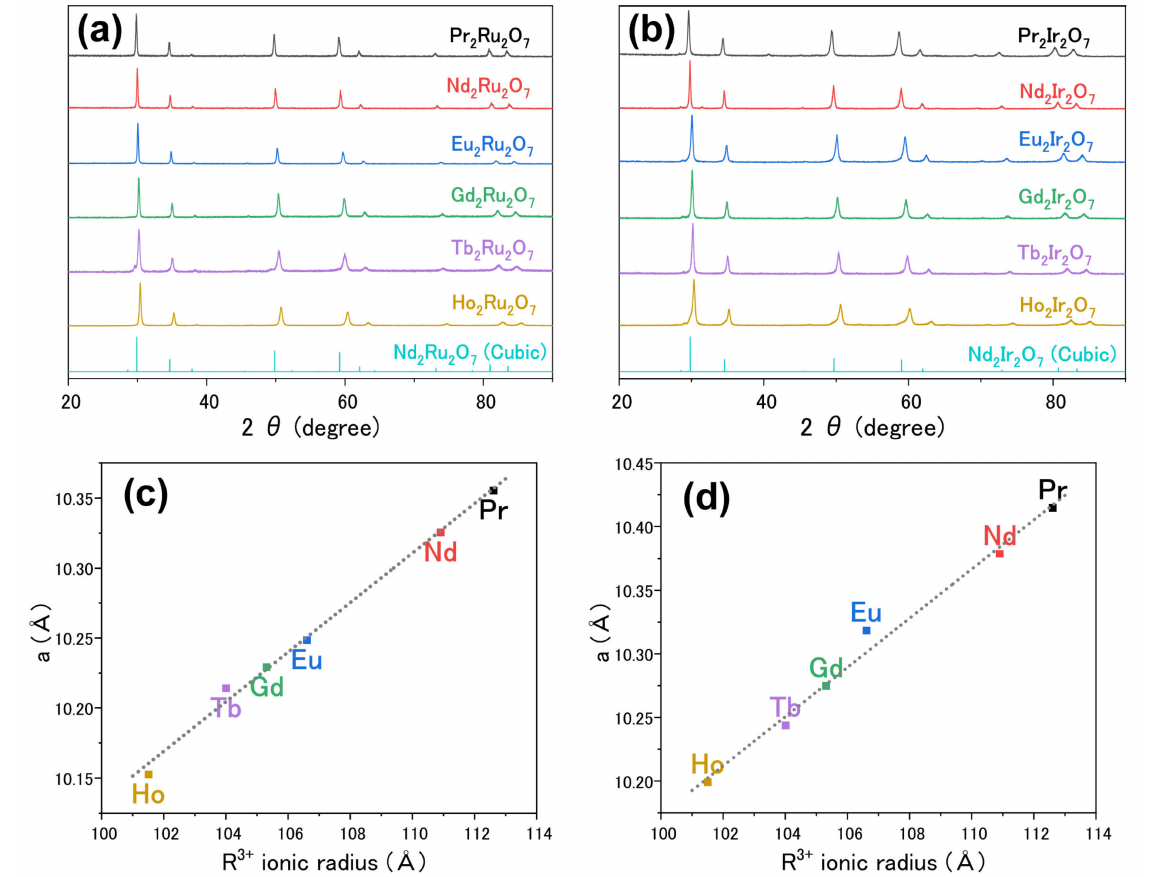
Figure 1. ( a , b ) Experimental XRD patterns of A 2 Ru 2 O 7 and A 2 Ir 2 O 7 where A = Pr, Nd, Eu, Gd, Tb, and Ho, using cubic Nd 2 Ru 2 O 7 (ICSD #79327) and Nd 2 Ir 2 O 7 (#239644) as reference samples. ( c , d ) Lattice constants a of A 2 Ru 2 O 7 and A 2 Ir 2 O 7 plotted against the ionic radii of R 3+ . The dotted lines serve as a visual guide.